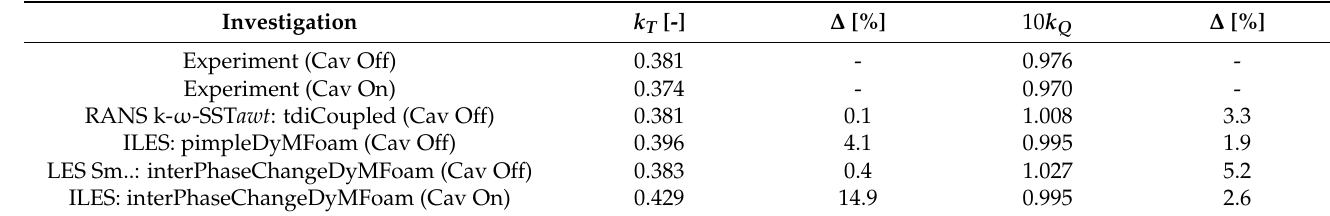
Table 6. PPTC’11. Integral values at J =